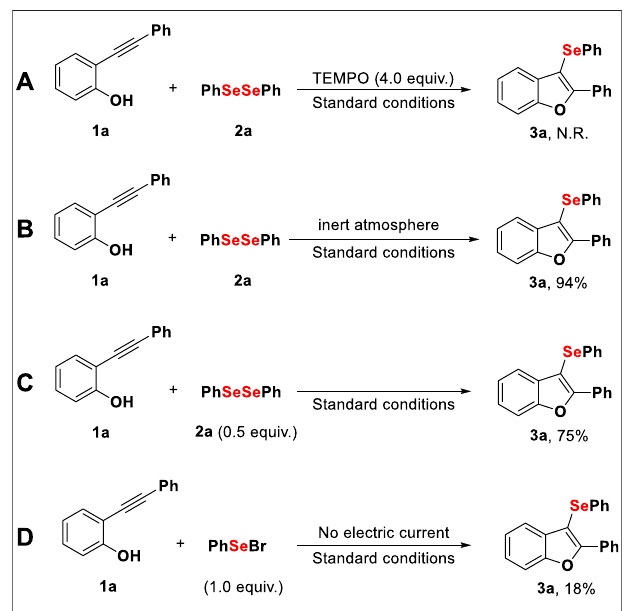
Scheme 4 | Control experiments. Standard conditions: platinum electrodes, constant current (10 mA), 1a (0.25 mmol), 2a (0.25